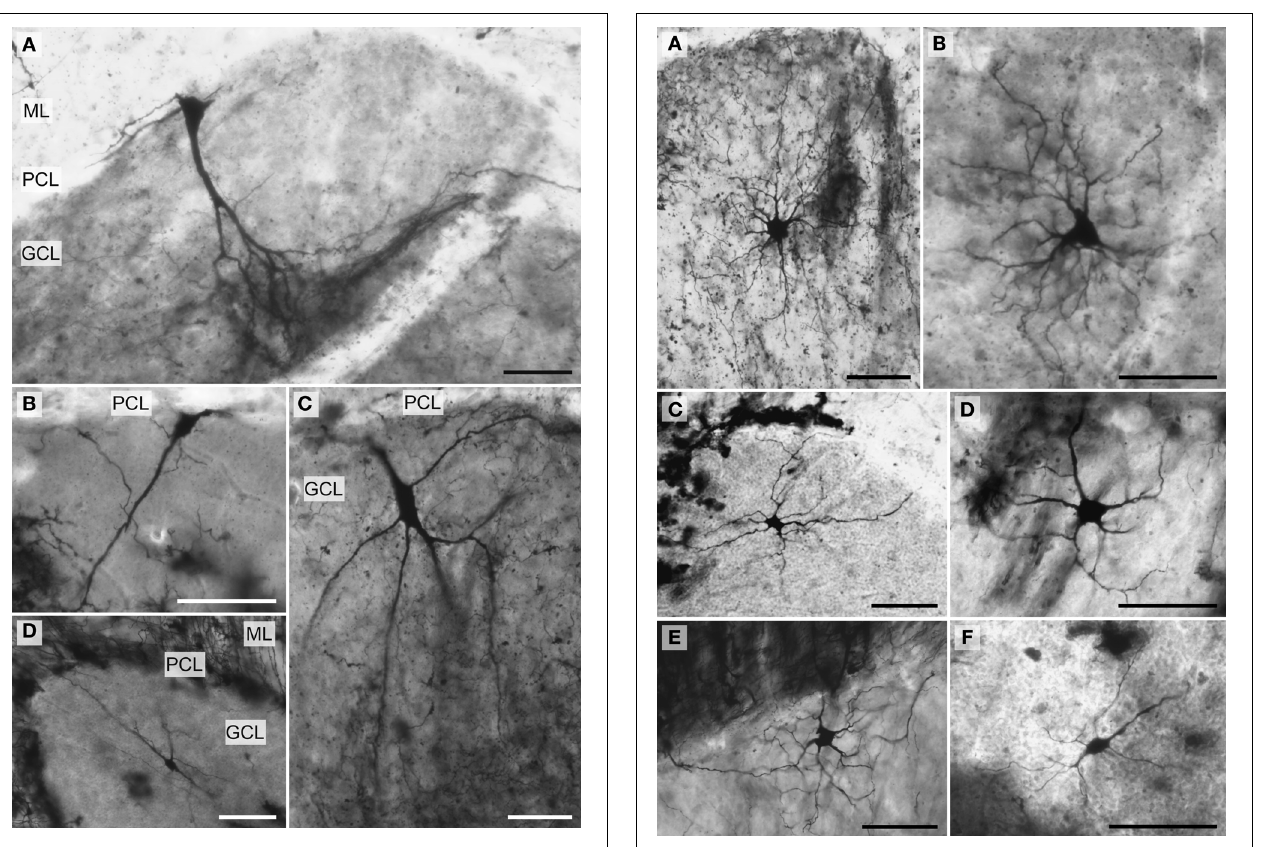
FIGURE 6 | Photomicrographs of Golgi-stained Golgi neurons. (A) and ( B , see also Figure 8H ) African elephant; (C) chimpanzee (see also Figure 11GG ); (D) Siberian tiger (see also Figure 9E ); (E) giraffe (see also Figure 10DD ); and (F) clouded leopard (see also Figure 9BB ). Scale bars: 100 μ